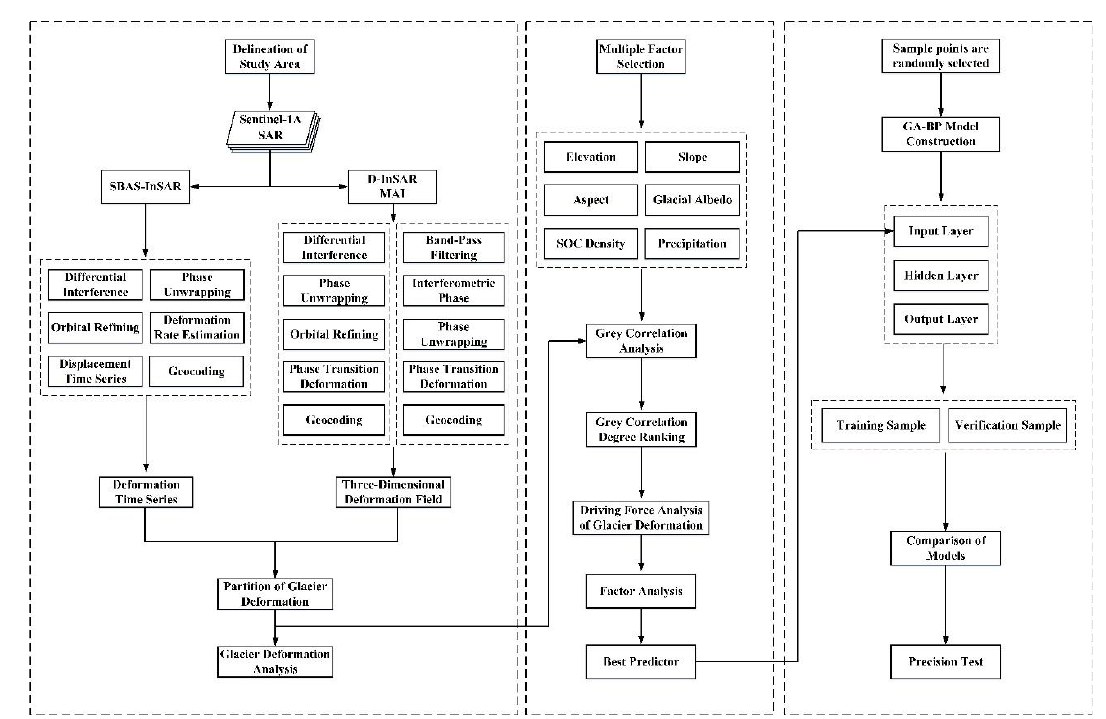
Figure 3. Technical flow